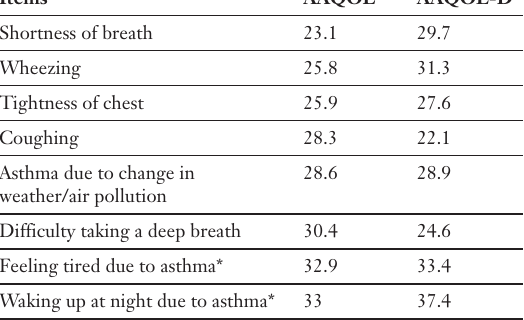
Comparison of clini- cal impact ranking (mean frequency (cid:2) mean importance) for the symptom domain (lower number indi- cates higher clinical